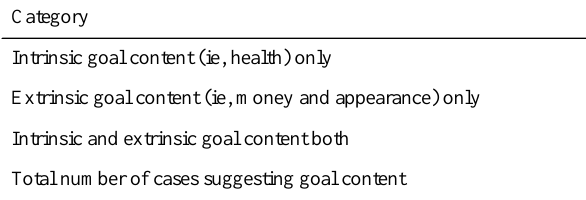
Board (Figure 1), Tobacco Control Research Branch at the National Cancer Institute in the United States (Figure 2), the European Commission (Figure 3), and the Korean Ministry of Health and Welfare (Figure 4). They tended to contain common